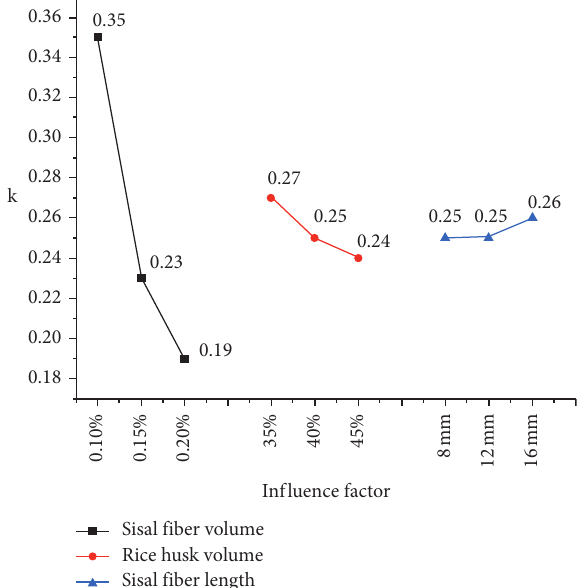
Figure 12: The k value diagram of the factors affecting the maximum seepage